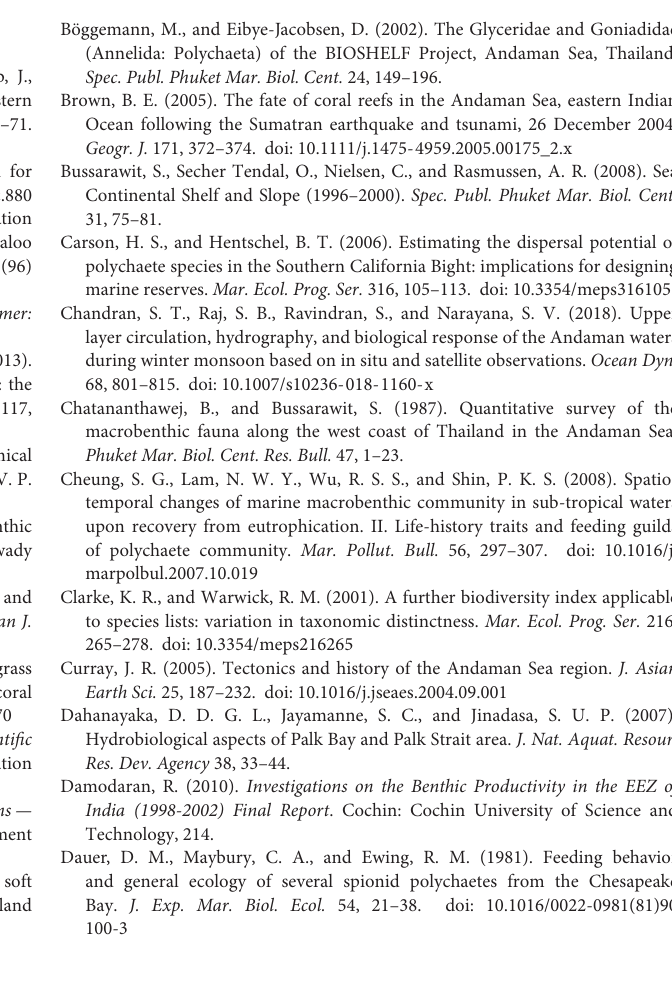
FIGURE S1 | Polychaete species from the Andaman and Nicobar Island margin. (A) Palmyreuphrosyne sp., (B) Armandia sampadae , (C) Paraprionospio pinnata , (D) Sphaerosyllis sp., (E) Pettibonella shopmens , (F) Rhamphobrachium